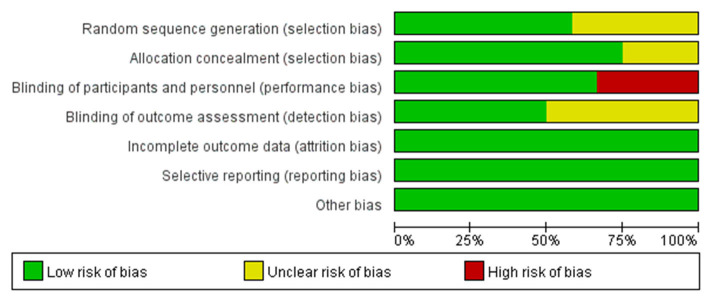
Risk of bias graph.